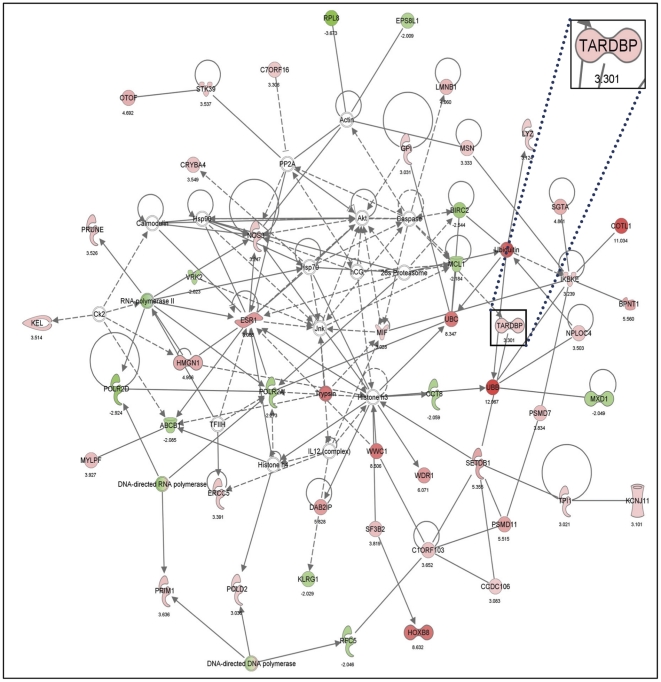
Protein interaction network map of hits from the RNAi screen.The data from the RNAi screen was processed to calculate MAD scores and was used for Ingenuity pathway analysis (IPA). The network annotated “Skeletal and Muscular System Development and Function, Tissue Morphology, Inflammatory Response" ranked at the top with the highest score and is shown in the figure. The hits that increased SOD1 levels above 3SD are shown in red and the ones that decreased the signal below −2SD are shown in green. The proteins represented by color-less nodes were below the selection criteria. Direct interactions are shown in bold lines and indirect interactions are shown in broken lines. (See Table S1 for proteins in this network)